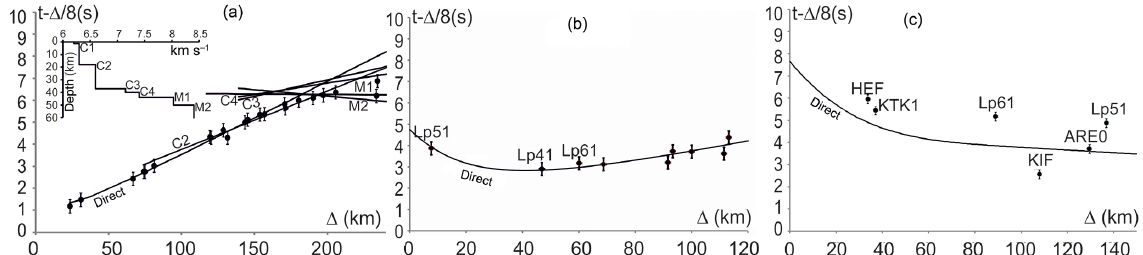
Figure 4. Result of relocation by HYPOELLIPSE: comparison of observed and calculated travel times (a) for shallow earthquake on 19 January 2008 at 19:52UTC, 67.23 ◦ N, 23.80 ◦ E, depth = 10.4km, ML = 2.2 (FENCAT); (b) for deep earthquake on 12 March 2009 at 22:42UTC, 67.41 ◦ N, 23.67 ◦ E, depth = 12.4km, ML = 1.0 (FENCAT); (c) for deep earthquake on 09 June 2007 at 02:52UTC, 68.68 ◦ N, 23.30 ◦ E, depth = 26.7km, ML = 1.7 (FENCAT).